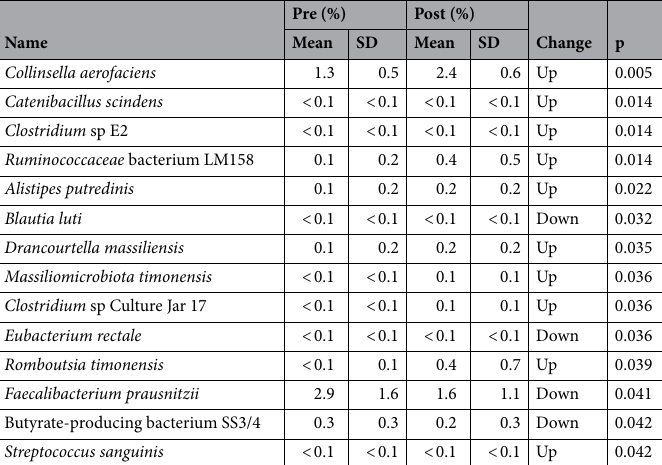
Table 2. Bacterial species with a significant change in abundance before (Pre) and after (Post) the